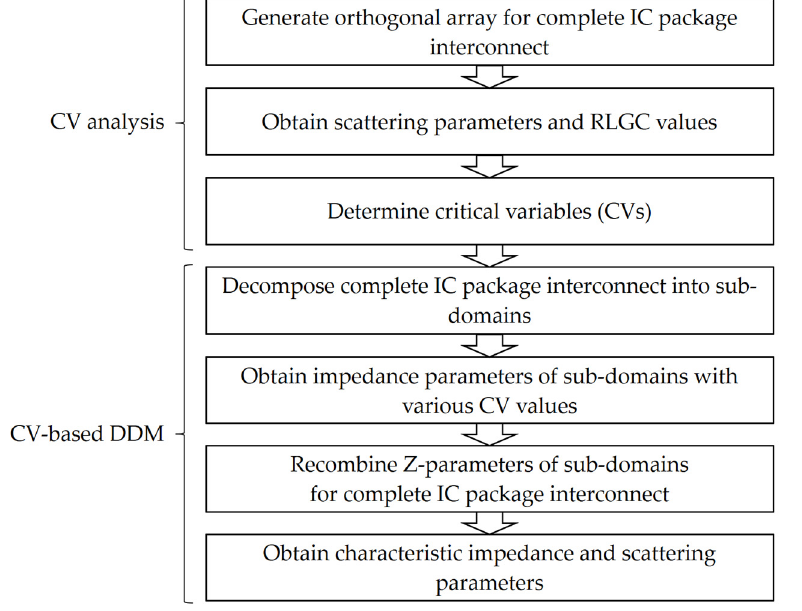
Figure 2. Overall procedure of the CVDDM (critical variable-based domain decomposition method).